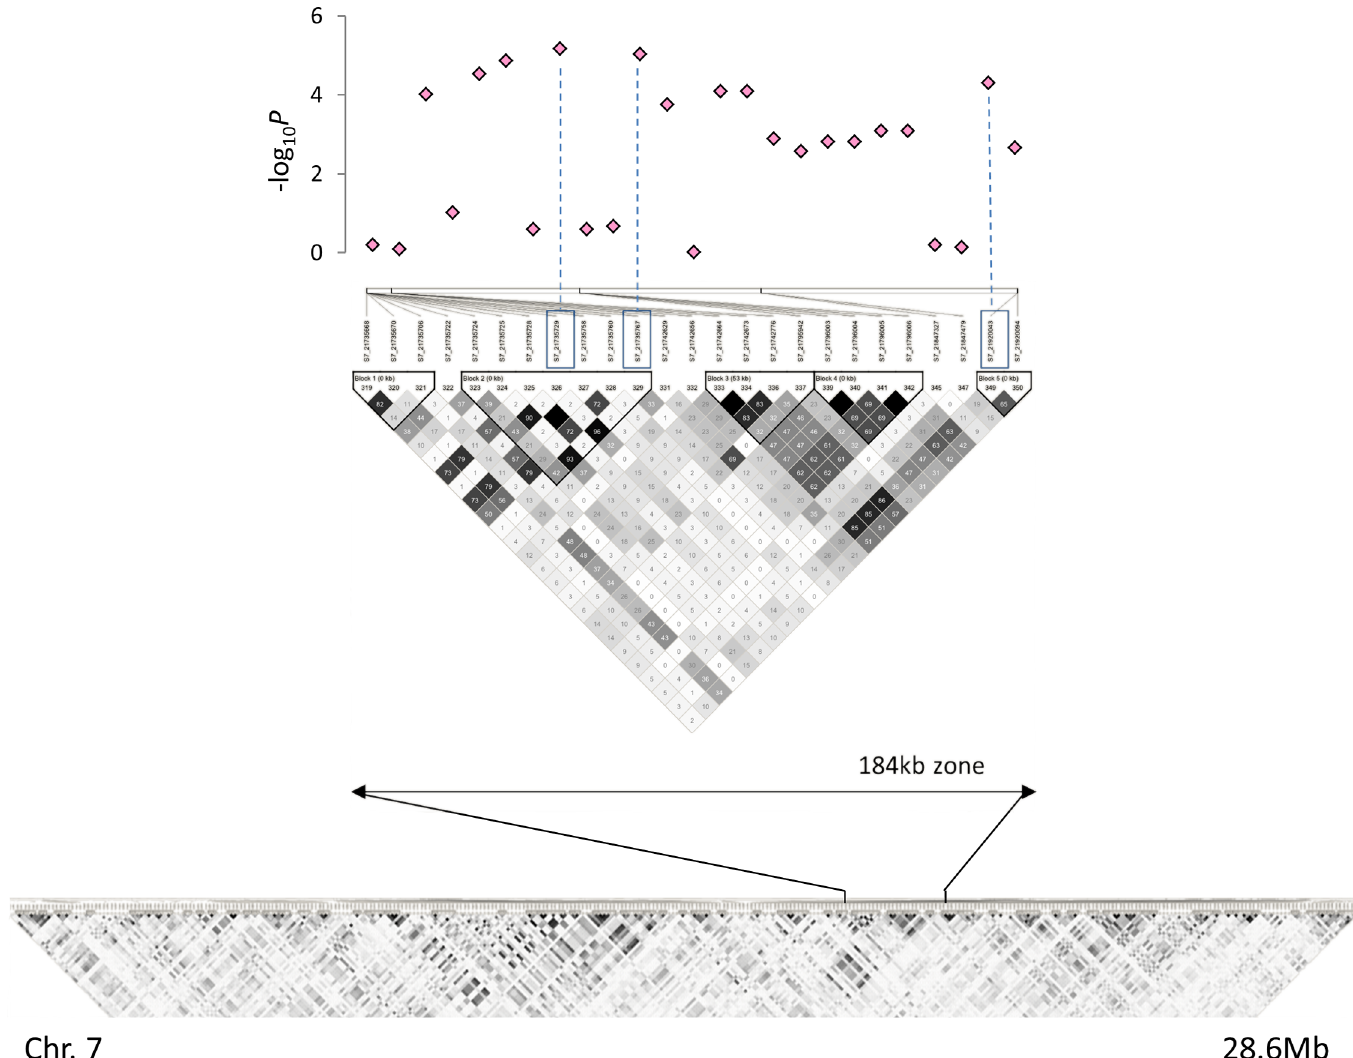
Fig 5. Local association plot for the approximate 184 kb candidate region detected on chromosome 7 and LD maps for the entire chromosome and the corresponding region. Dashed lines indicate the most significant